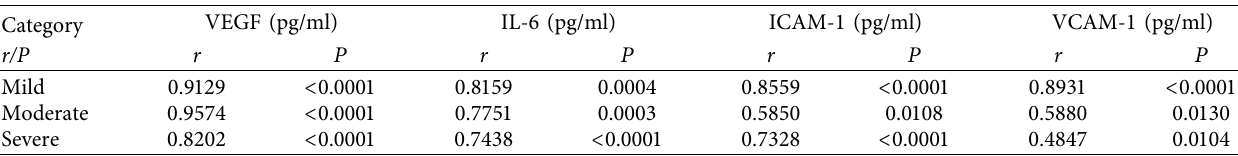
Table 5: Correlation analysis between the severity of ME and the expression levels of VEGF, IL-6, ICAM-1, and VCAM-1 in the aqueous humor.